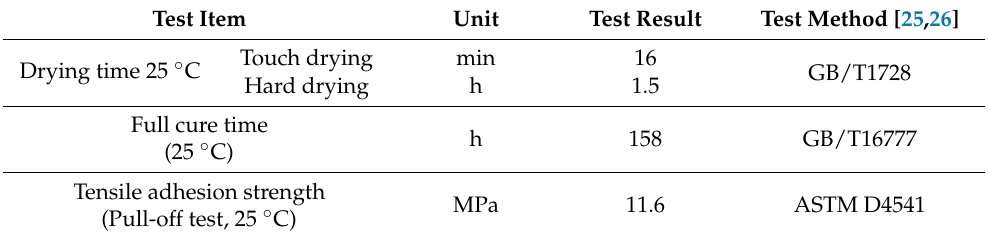
Table 2. Material properties of zinc-rich epoxy primer.